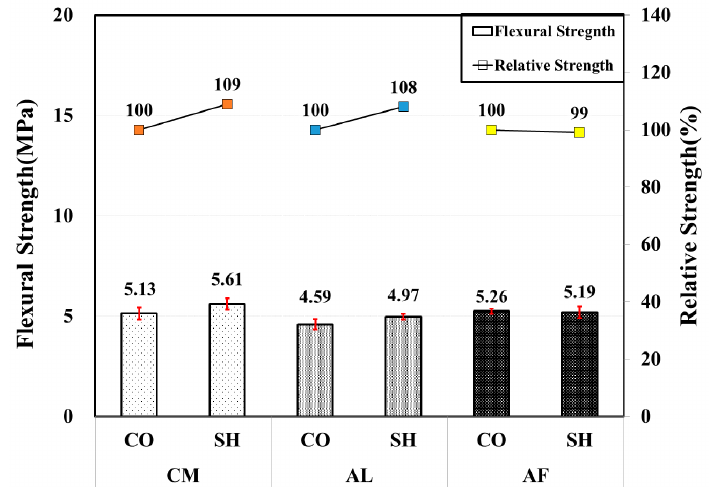
Figure 9. Flexural strength by accelerators for 3-month-old specimens.